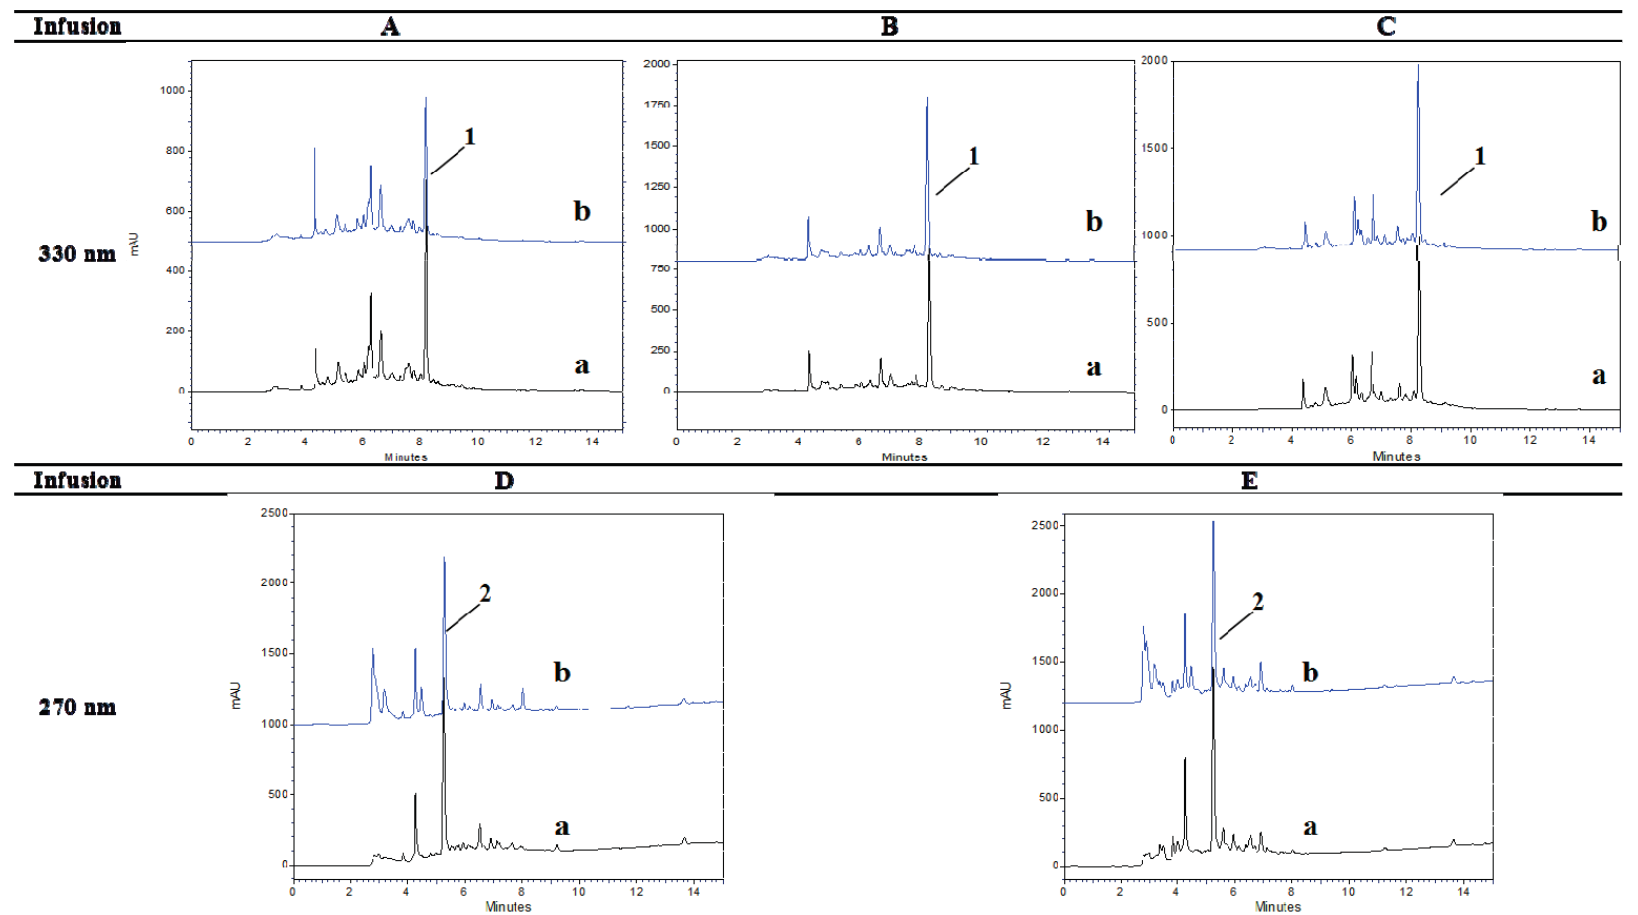
Figure 3. RP-HPLC-DAD profile of Infusions ( A – C ) at 330 nm and of Infusions ( D ) and ( E ) at 270 nm before (a) and after (b) simulated digestion. Peak assignment: Peak 1, rosmarinic acid; Peak 2, (+)-catechin. Chromatographic conditions were as described in the Experimental